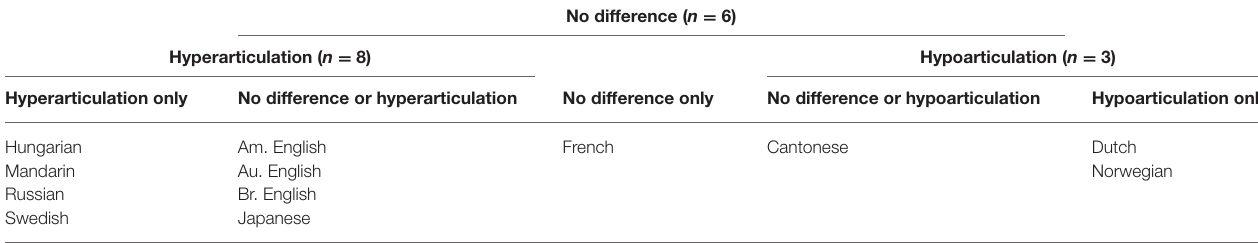
TABLE 1 | Languages for which hyperarticulated IDS, hypoarticulated IDS, or no difference between speech registers has been reported. No difference ( n =